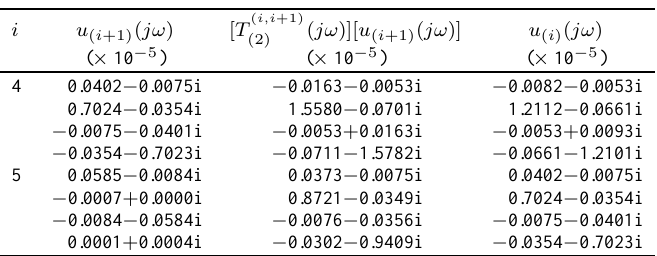
Table 6 Validation of relationship Eq.